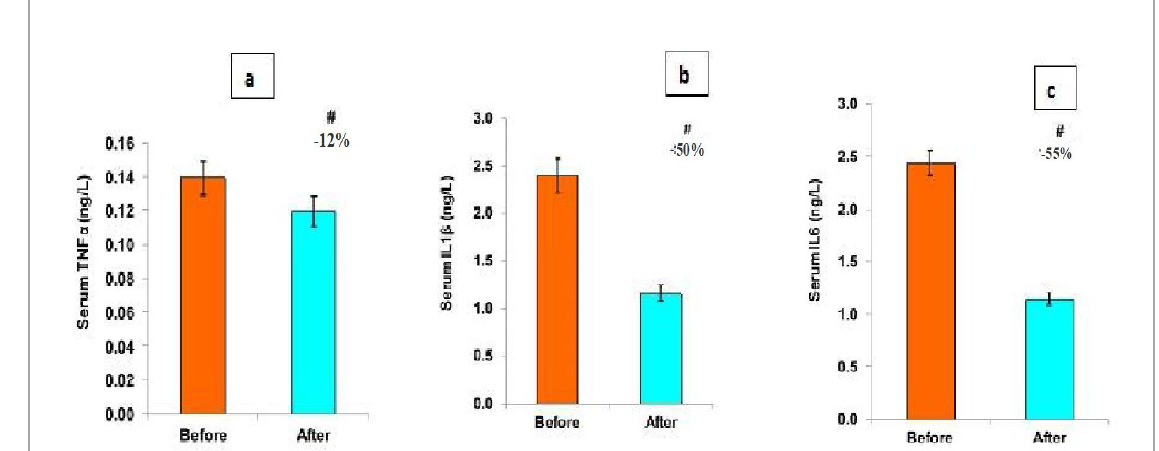
Figure 2 . The effect of the honey treatment on patients serum level of (a) IFN-γ, (b) IL1β, and (c) IL6.